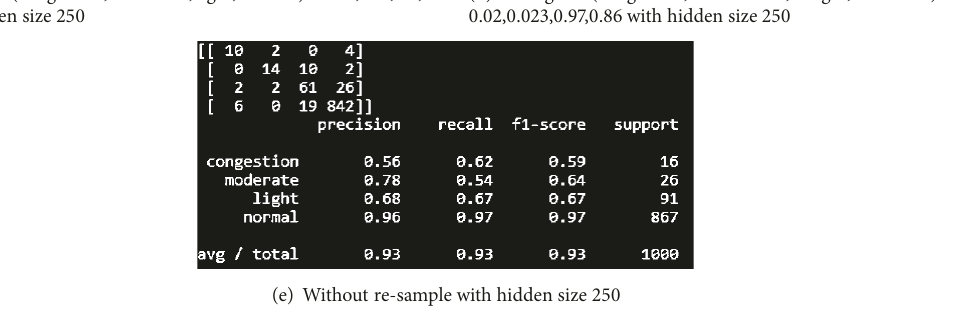
Figure 7: The confusion matrices with different re-sample weights and different hidden sizes. The confusion matrices are set with rows from congestion to normal from top to